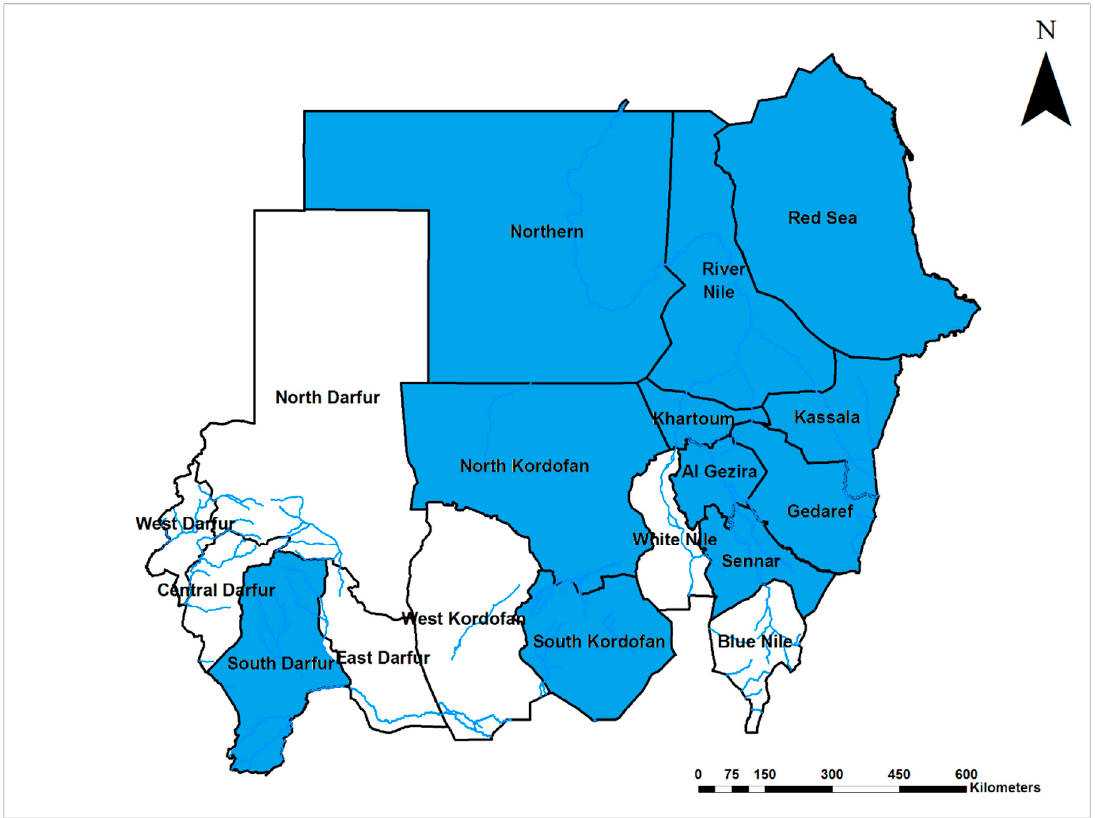
Figure 5. Map of Sudan showing the prevalence of chikungunya virus infections (Blue).